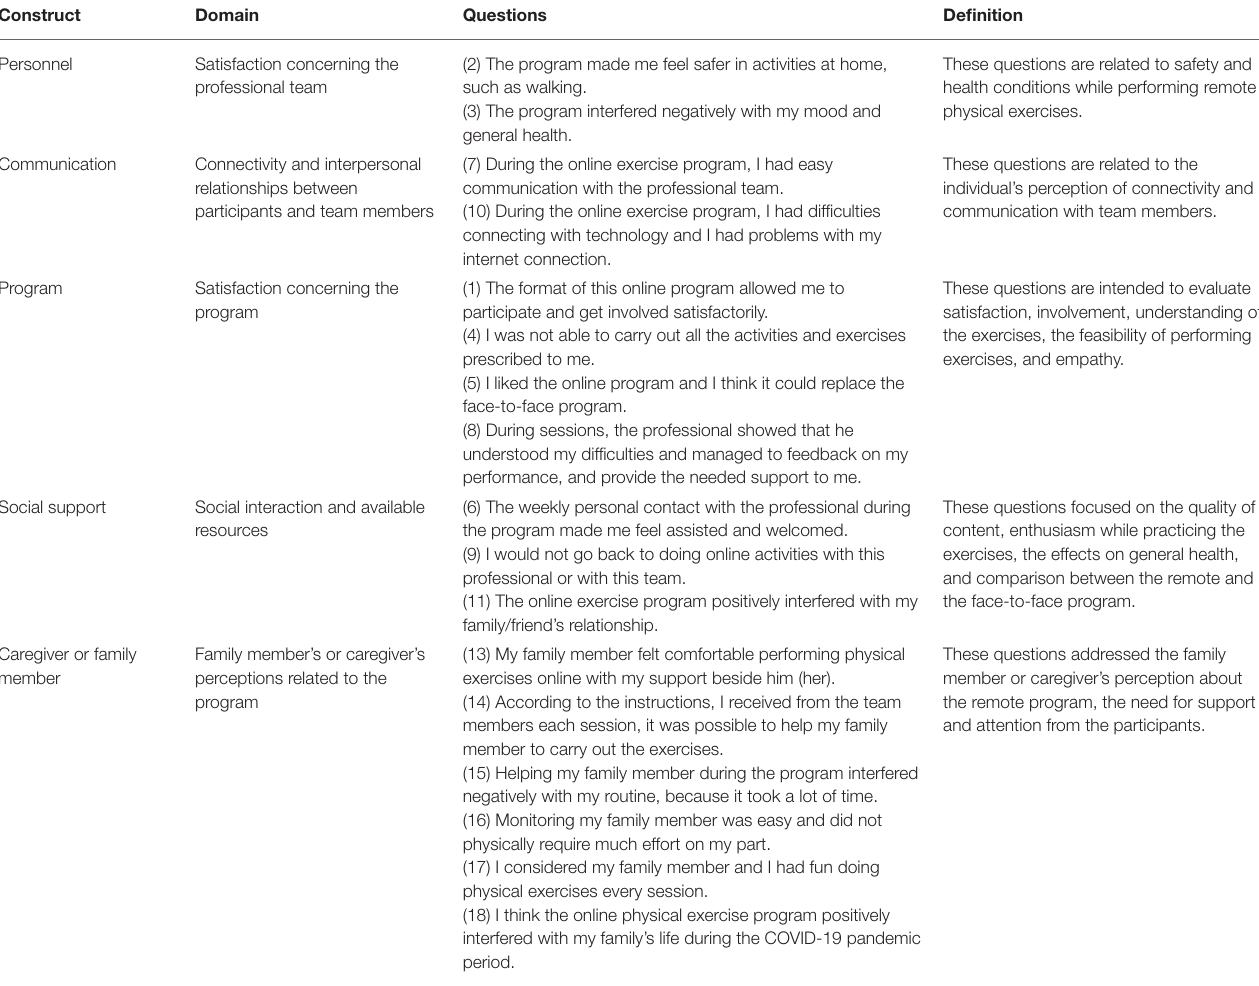
TABLE 2 | Constructs, subdomains, and definitions of the overall experience